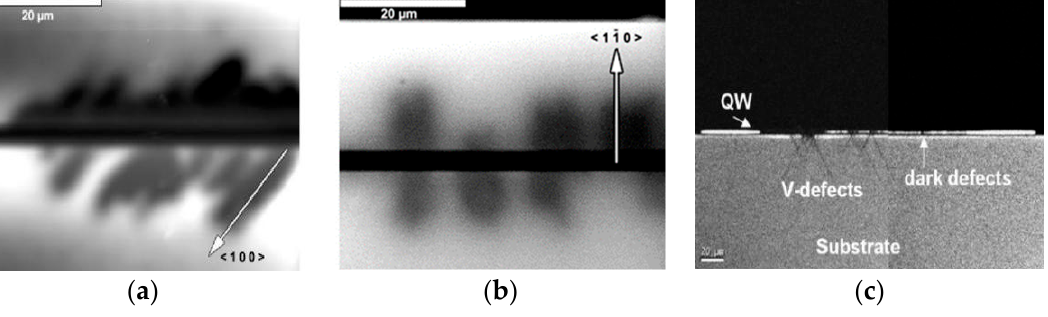
Figure 13. DLDs observed by the CL technique. ( a ) CL image of DLDs at 45° to the cavity, ( b ) CL image of DLDs perpendicular to the cavity, and ( c ) CL image of V-shaped defects. Reprinted with permission from ref. [18] © Elsevier. Copyright 2013 Microelectronics Reliability.